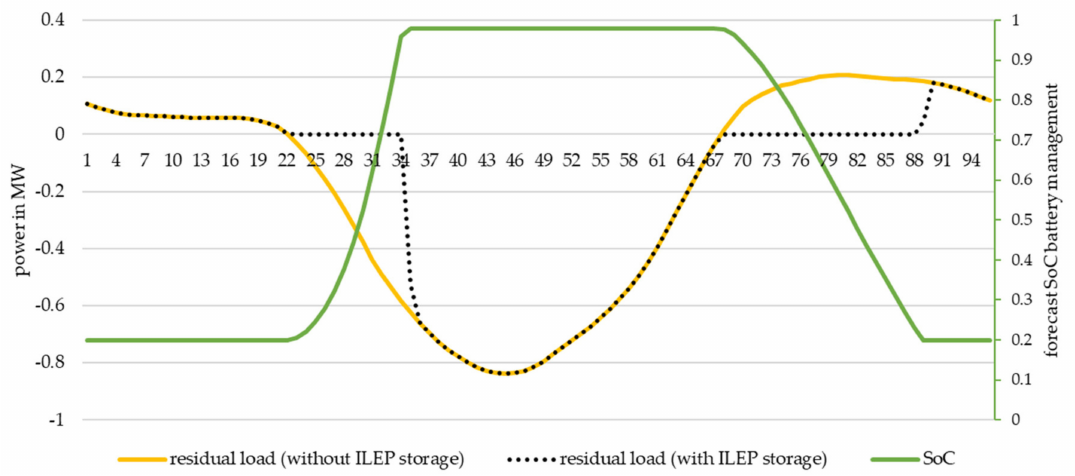
Figure 8. The resulting battery storage forecast with load concept 1 for the example day (17 July 2019), TSO substation Dresden Süd: battery SoC over a day (green), the residual load with the used ILEP concept (dashed black), and the residual load without consideration of storage (yellow). The residual load is the sum of the generation, load and battery charge / discharge.